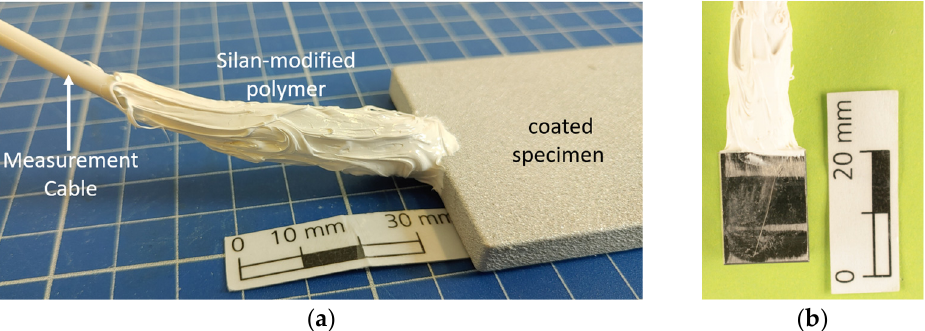
Figure 3. ( a ) The electrical connection of a thermal spray-coated specimen with insulation by silan- modified polymer sealant; ( b ) A bare steel specimen with the electrical